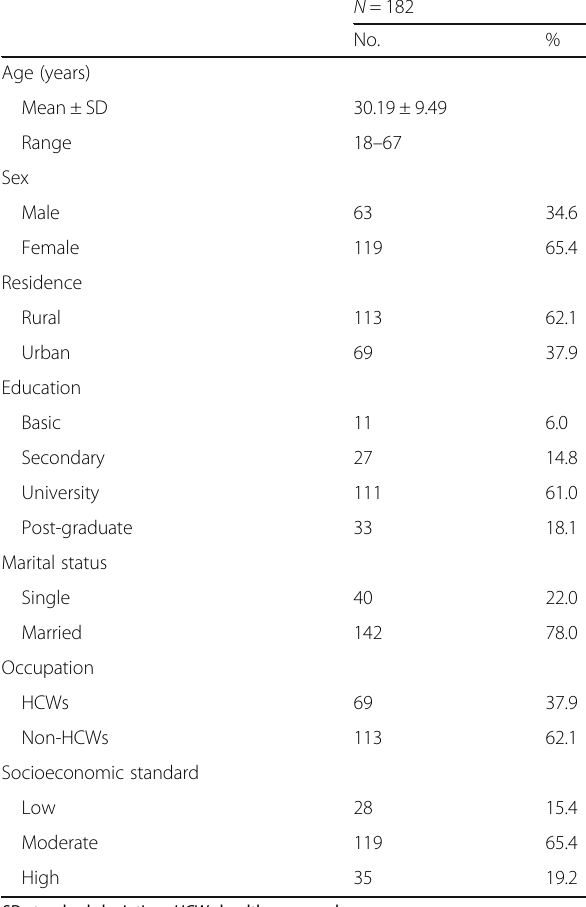
Table 1 Characteristics of the studied participants